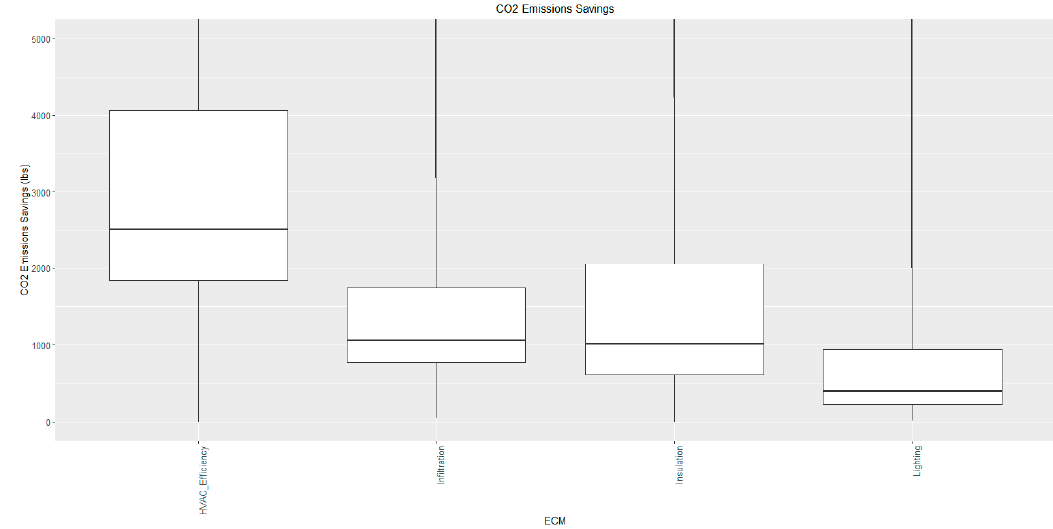
Figure 10. Distribution across buildings in the utility’s service area of operational emissions savings for four traditional energy efficiency measures.